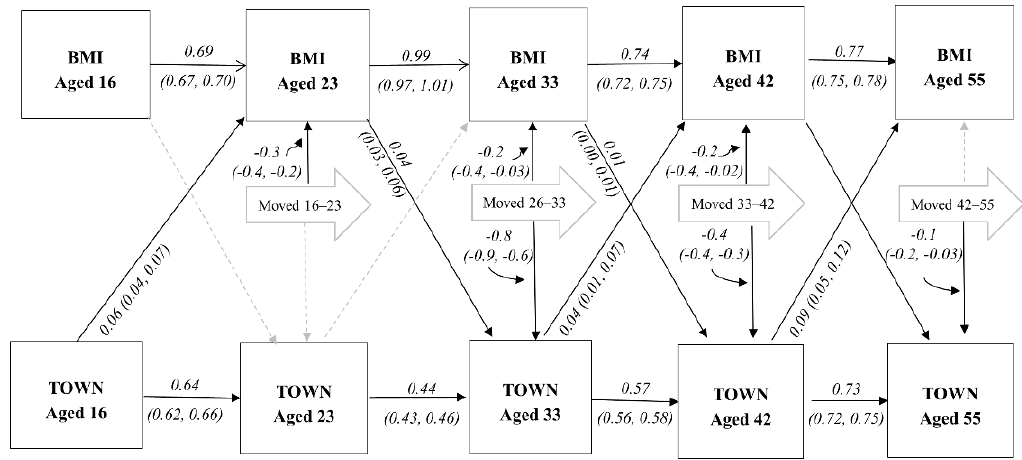
Figure 3. Structural equation model with both area deprivation, health selection and mobility paths across the life course: 1958 British Cohort ( n = 18,555). Dotted line indicates non-significant paths ( p > 0.05). BMI = body mass index; TOWN = Townsend area deprivation score.